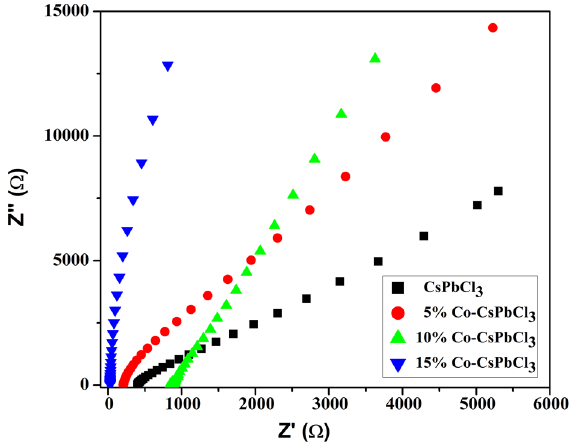
Figure 12. Nyquest plot of CsPbCl 3 and Co:CsPbCl 3 .